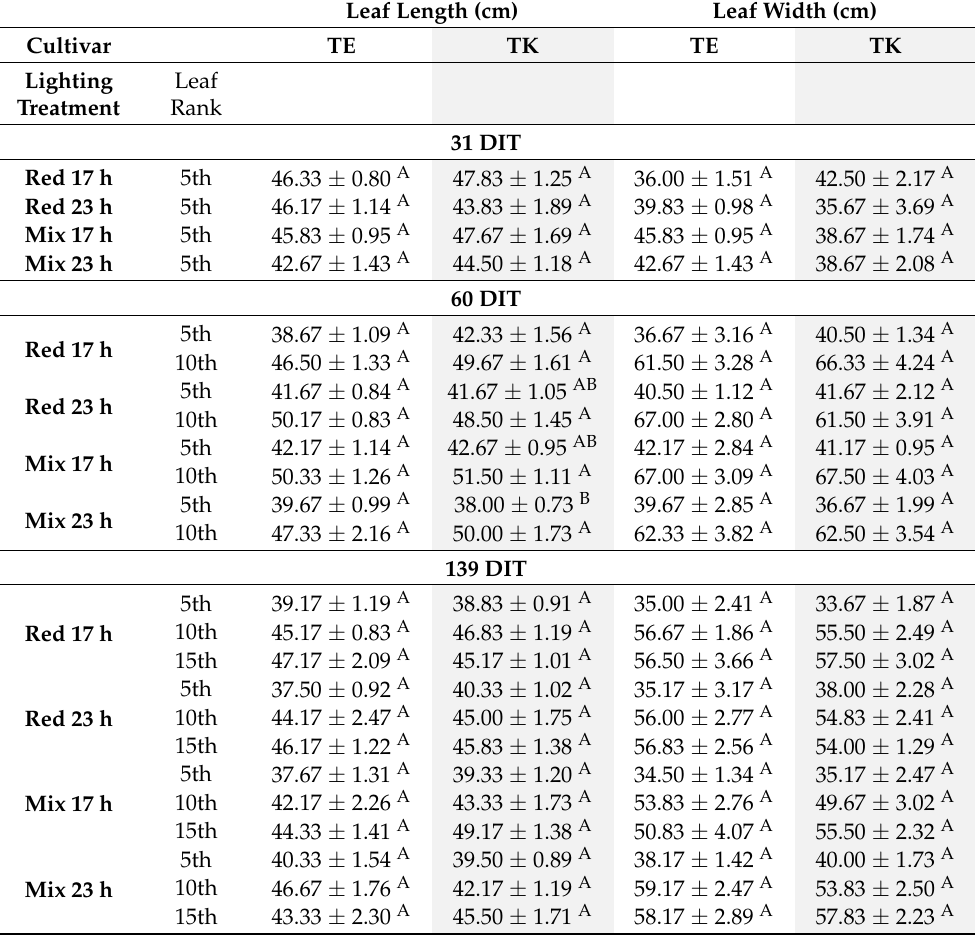
Table 4. Leaf parameters of plants grown under red 17 h, red 23 h, mix 17 h, and mix 23 h at 31 (16 December 2018), 60 (14 January 2019), and 139 DIT (3 April 2019). Values ± the standard error of the mean are representative of n = 6 for TE and TK plants under all lighting treatments. TE values are under white columns while TK values are under shaded columns. Different letter groups (A, B) represent a statistical difference between rootstocks and lighting treatments within a time point, leaf rank, and leaf parameter at p <